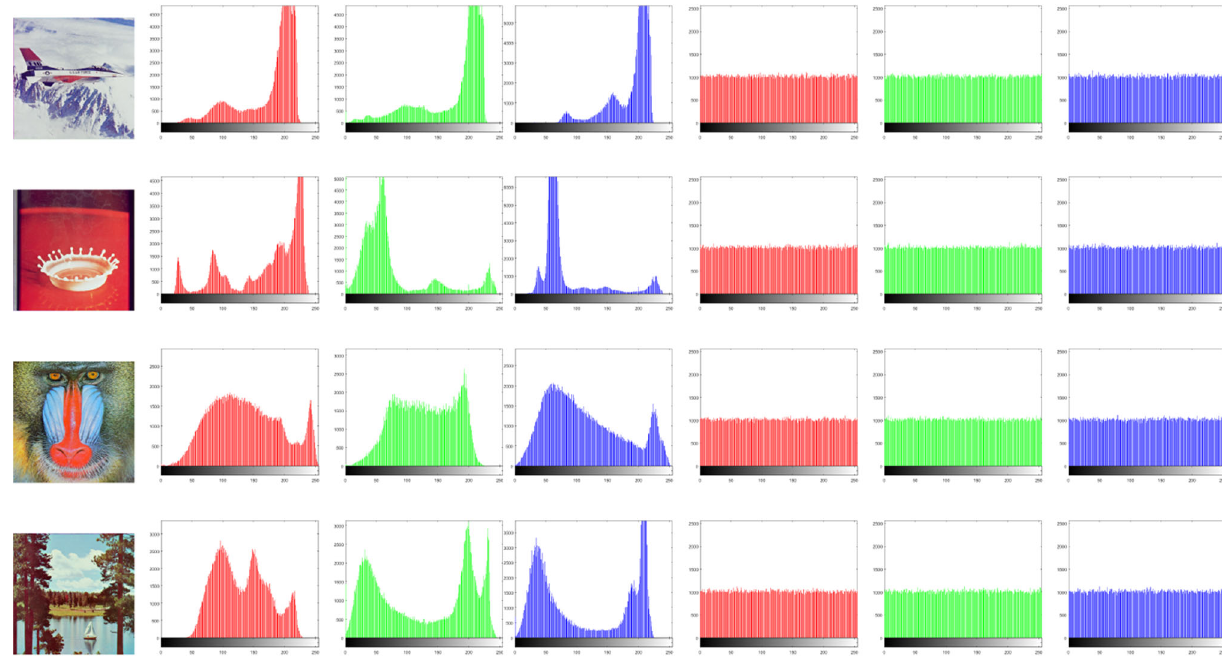
Fig.7 Histograms of the investigated dataset, in which the histograms of encrypted images are given in the latest three columns and are completely having an identical distribution, while the other three columns signify the histograms of original